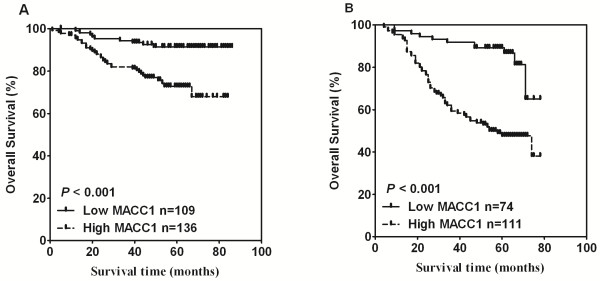
MACC1 expression and overall survival analysis. A. Kaplan-Meier curves with univariate analysis (log-rank) for patients with low- versus high-MACC1 expression tumors in cohort 1. B. Overall survival analysis and comparison in patients with high- and low-MACC1 groups in cohort 2.